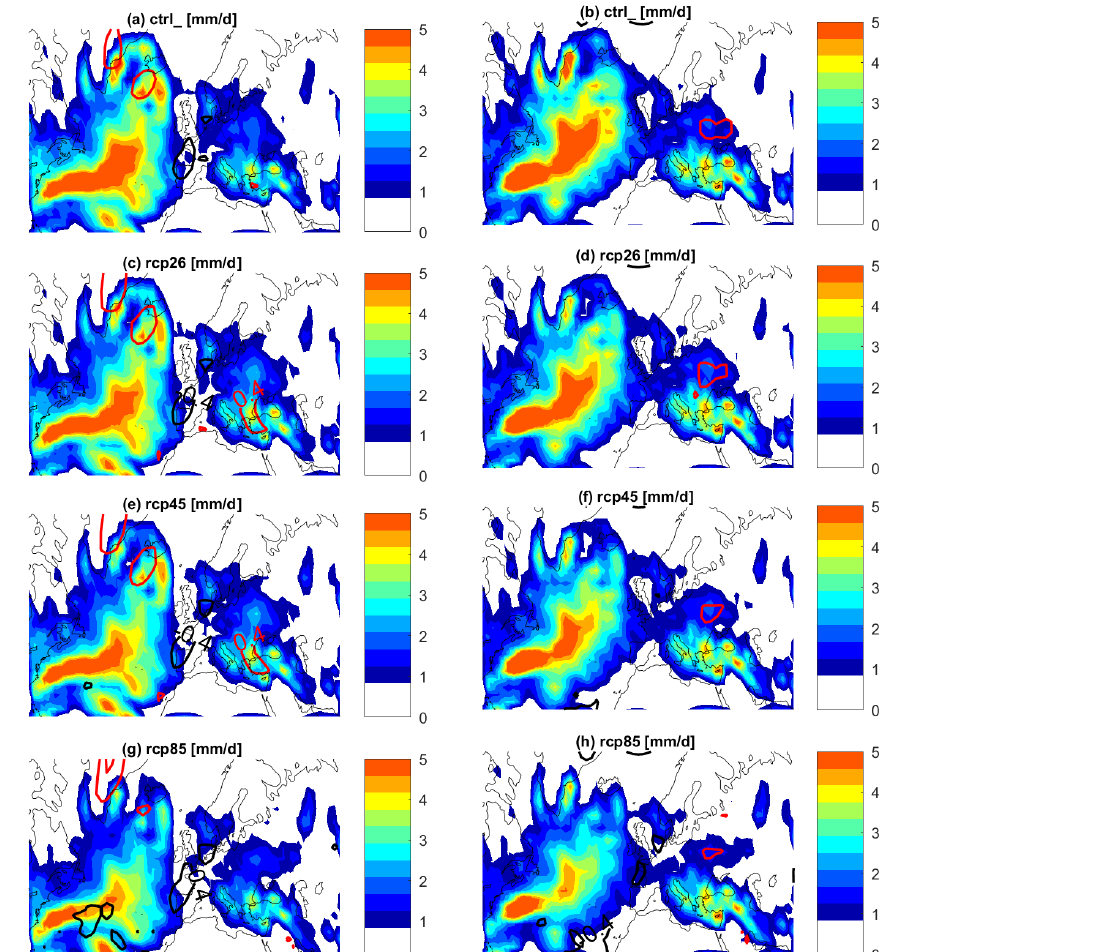
Figure 10. Daily precipitation rates in PlaSim simulations: average of the daily precipitation rates [mmd − 1 ] for cluster 1 (a, c, e, g) and cluster 2 (b, d, f, h) of analogues. (a, b) Control run. (c, d) RCP2.6 run. (e, f) RCP4.5 run. (g, h) RCP8.5 run. Isolines represent positive (in red) and negative (in black) standardized